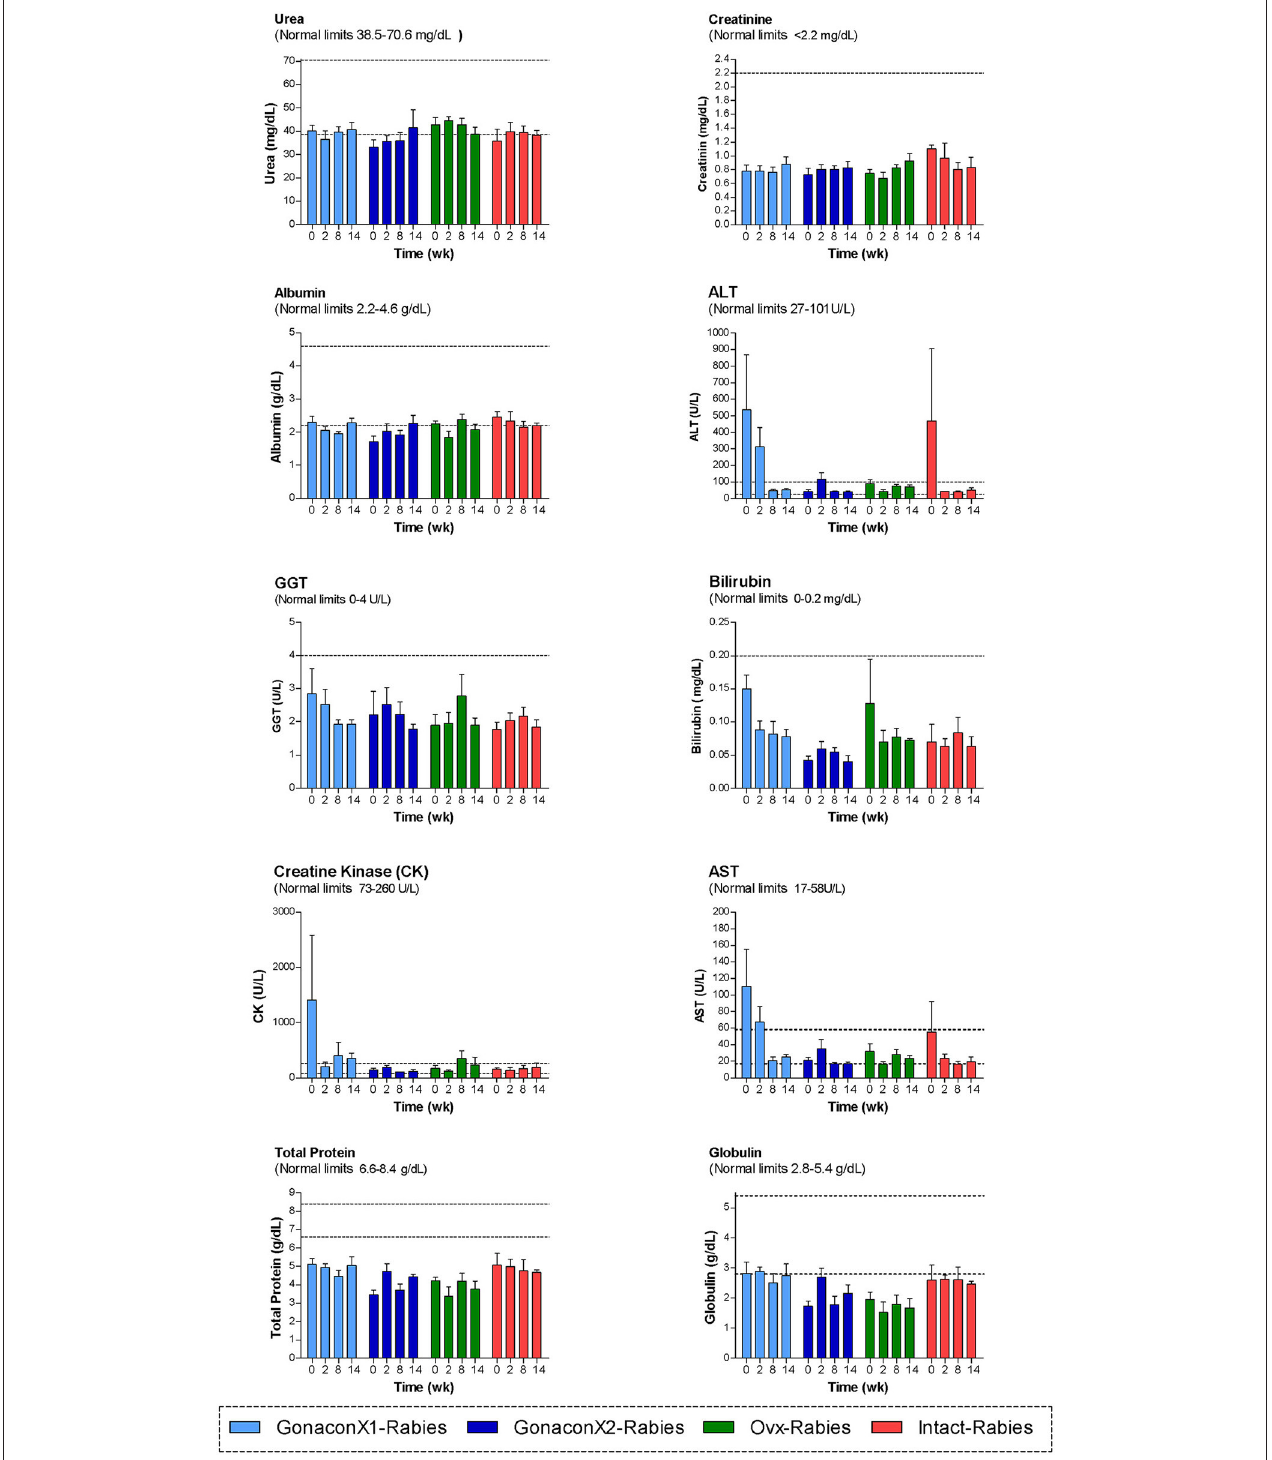
FIGURE 4 | Blood chemistry parameters of cats in the research groups. Mean ± SEM of blood chemistry parameters are presented for each group: GonaconX1-Rabies: cats vaccinated with both Gonacon and rabies ( n = 5); GonaconX2-Rabies: cats vaccinated twice with Gonacon (3 weeks apart) and with rabies ( n = 4); OVx-Rabies: cats ovariohysterectomized and vaccinated with rabies ( n = 4); Intact-Rabies: cats vaccinated against rabies and remained intact ( n = 3). Analyses were performed on blood samples collected at 0, 2, 8, and 14 weeks after the initial vaccination. Dotted lines indicate normal limits. ALT, alanine aminotransferase; GGT, gamma-glutamyl transpeptidase; AST, aspartate aminotransferase.